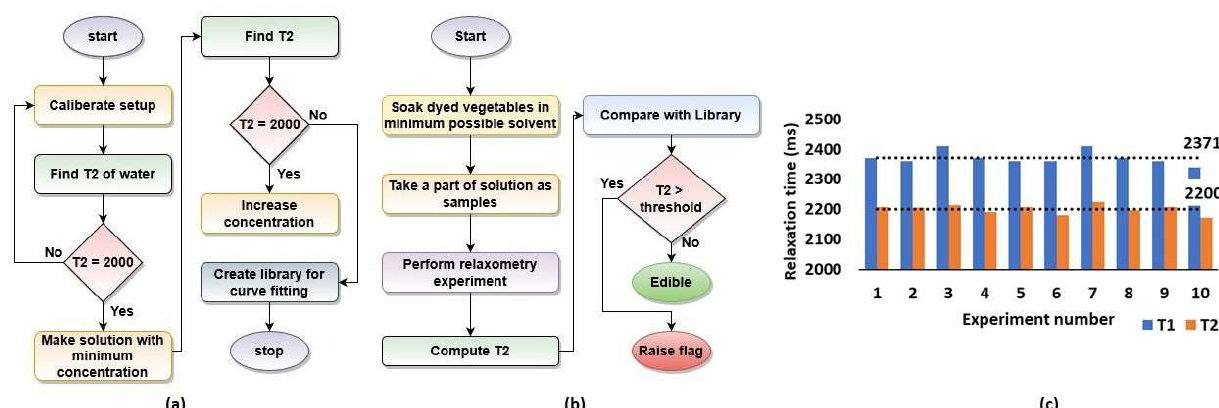
Figure 3. ( a ) Flowchart showing the process of creating a library; ( b ) flowchart showing the process of determining unknown concentrations; ( c ) measured variation of T 1 and T 2 values for the reference sample (DI water) over 10 experiments.